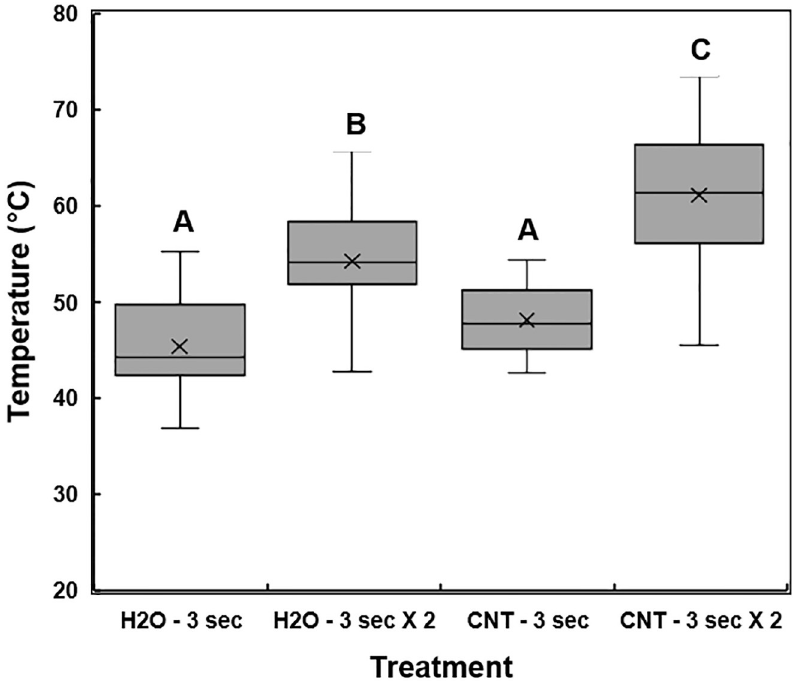
Fig 6. Temperature measurements in the scions following sterile deionized water (dH 2 O) or multi-walled carbon nanotube (MWCNT) treatment and microwave exposure. Scion samples were first treated with dH 2 O or MWCNT and then exposed to microwave radiation for 3 sec or 3 sec with two iterations (6 sec total). A thermal camera was used to perform 3-point measurements on the proximal, central, and distal sections of the treated scion wood. The sample treatments are plotted against the average temperature readings from each section of the scions. The 5-number summary statistic, represented as a box and whisker plot, includes the minimum, 1 st quartile, median, 3 rd quartile, and the maximum temperature values calculated for each microwave irradiation treatment. The X within each box represents the treatment mean. Different letters indicate significant